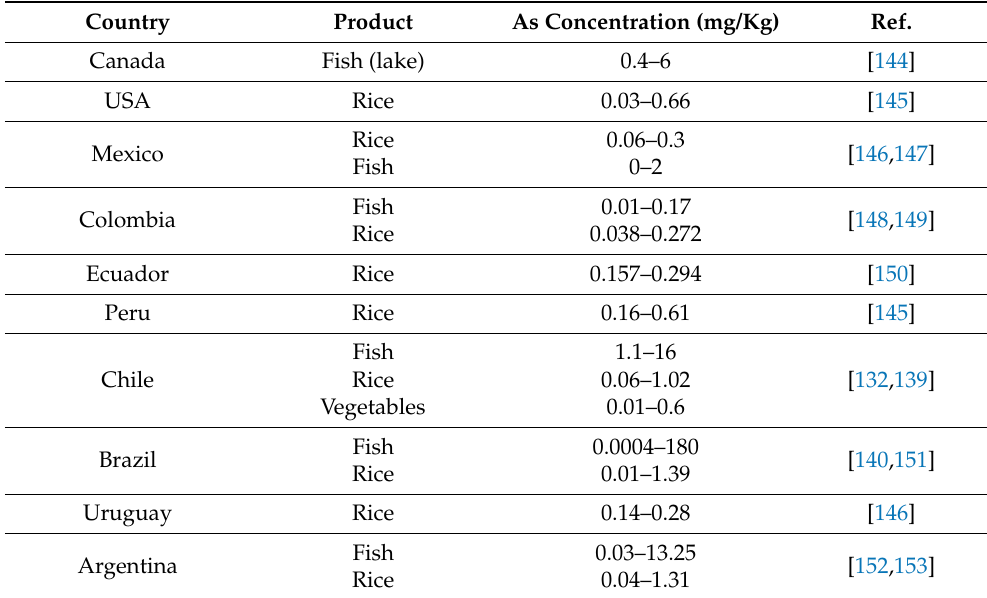
Table 6. Foods affected by arsenic contamination in America (selected data from recent